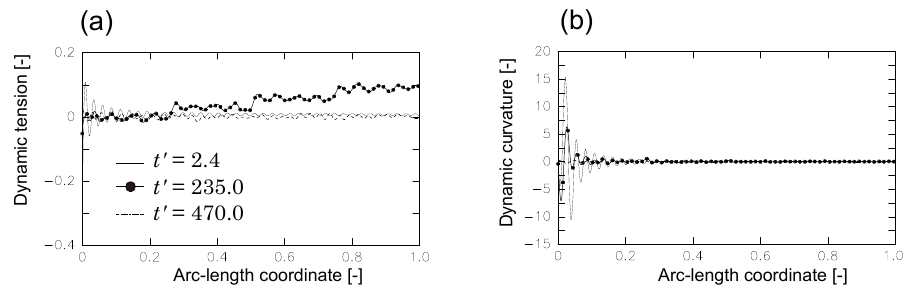
Figure 12. Distributions of ( a ) dynamic tension and ( b ) dynamic curvature for four buckets. t (cid:48) denotes dimensionless